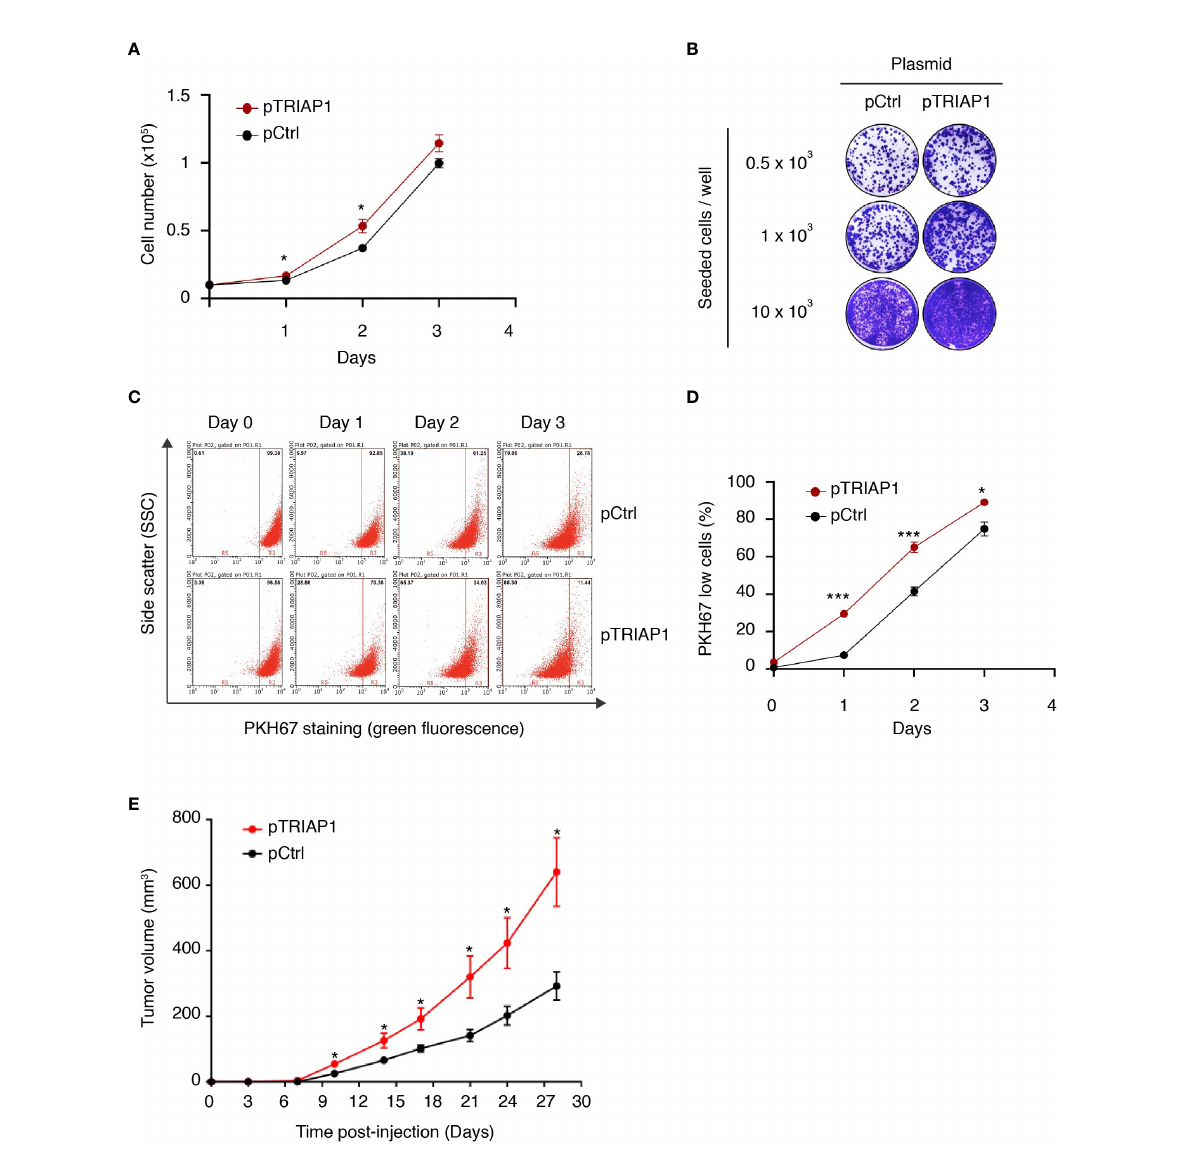
FIGURE 1 TRIAP1 overexpression supports HCT116 cancer cell proliferation and tumorigenesis. (A – E) HCT116 cells were transfected with the control (pCtrl) or TRIAP1-overexpressing (pTRIAP1) plasmids. (A) Control (pCtrl) and TRIAP1-overexpressing (pTRIAP1) cells were seeded (10 4 cells) in standard culture medium, and their proliferation rate was determined every day by manual counting. Data are represented as mean ± SEM of triplicates. (B) Similar cells were analyzed (crystal violet staining) for their capacity to form colonies at low density (clonogenic assay). (C) Monitoring of the proliferation rate of control (pCtrl) and TRIAP1-overexpressing (pTRIAP1) HCT116 cells using fl ow cytometry and the vital lipophilic fl uorescent dye PKH67, which is lost upon cell proliferation. One day after staining with PKH67, cells were analyzed by fl ow cytometry on the indicated days. At day 0 (16 h after staining), all the cells have a high intensity of fl uorescence (PKH67 High). The decrease in fl uorescence (PKH67 Low), which is observed at the indicated time points, correlates with the proliferation of the labeled cells. The separation of the two populations (PKH67 High and PKH67 Low) is indicated with a red bar. (D) Quanti fi cation of data in (C) . Data are represented as mean ± SEM of triplicates. (E) Growth curves of HCT116 tumors developed as xenografts in athymic mice. Nude mice were subcutaneously injected with 5 × 10 6 HCT116 cells transfected with the control (pCtrl) or TRIAP1-overexpressing (pTRIAP1) plasmid. On the indicated days post injection, tumor volumes were measured as described in the Material and Methods section. Data are represented as the mean ± SEM. For statistical comparison, Student ’ s t -tests were performed *p < 0.05; ***p <